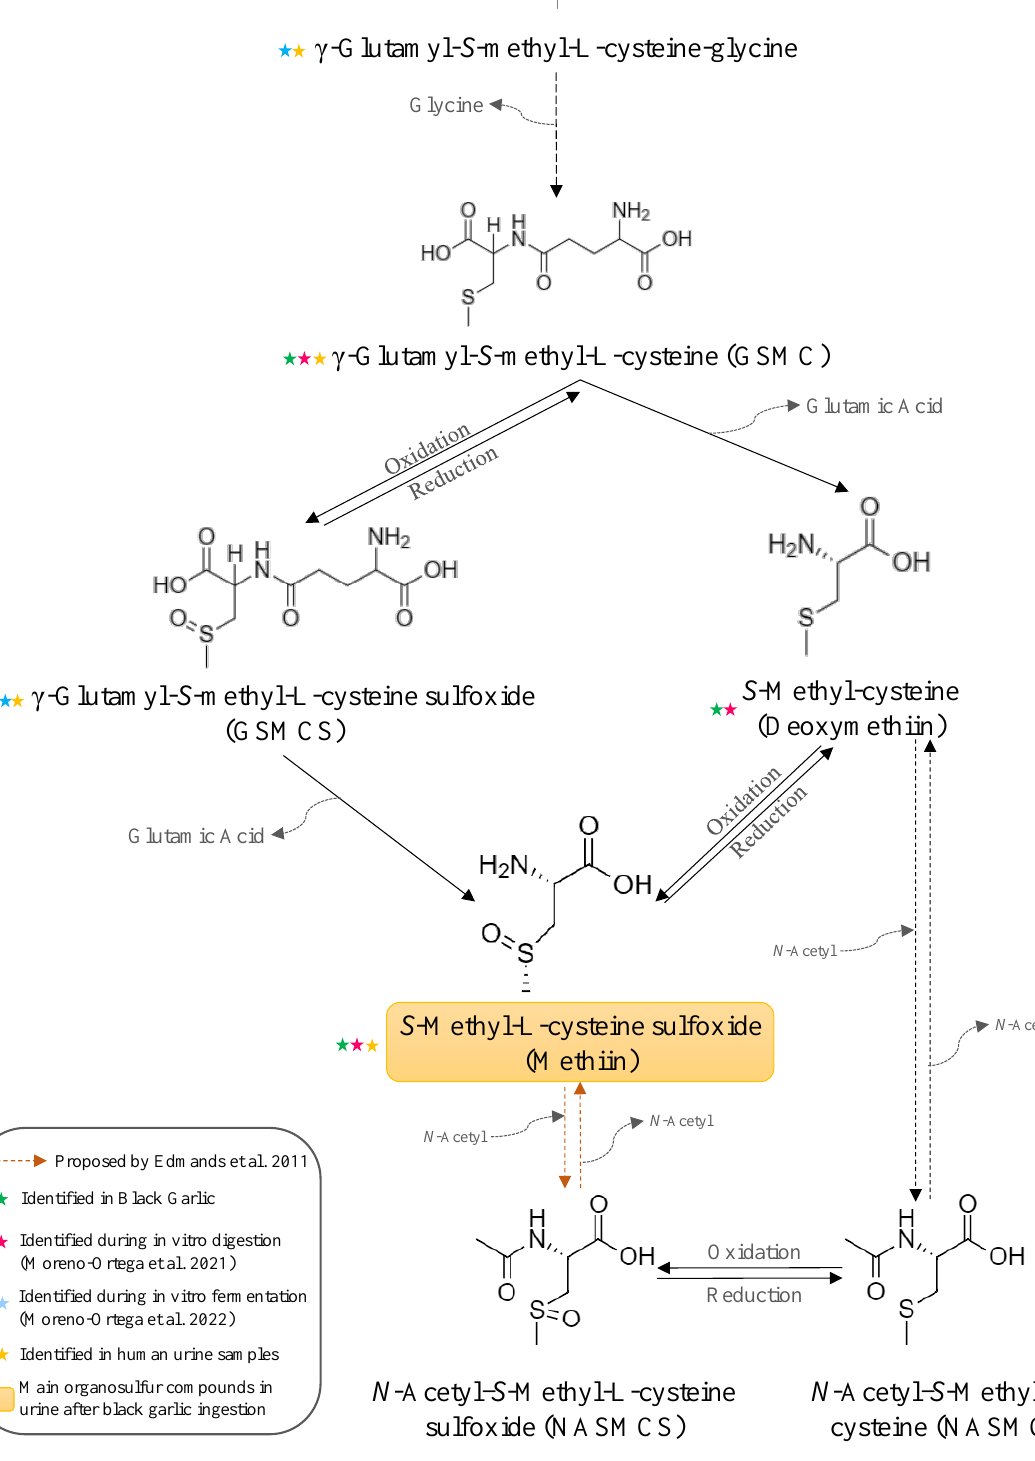
Figure 5. Degradation pathway proposed of γ -Glutamyl- S -methyl-L-cysteine-glycine based on the reports of Edmands et al., 2011 [48]. Boxes with compounds indicate the main components excreted in urine after black garlic intake.